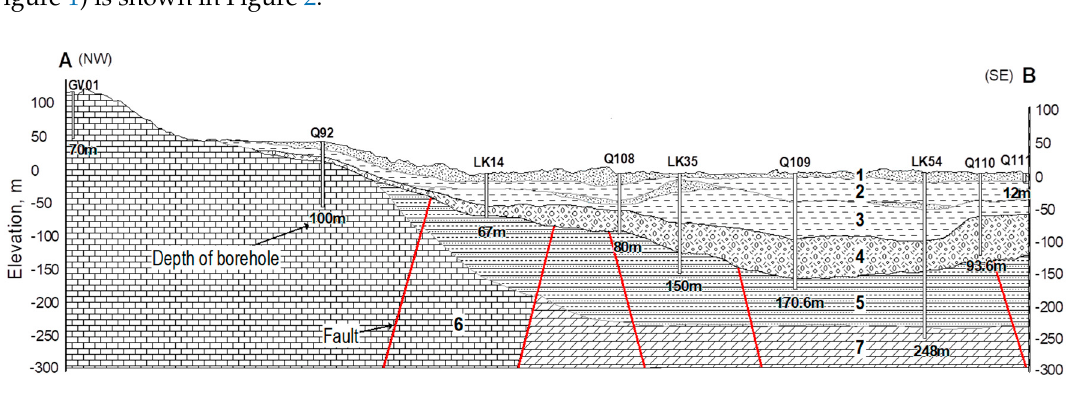
Figure 2. Geological setting of the study region drawn for the transect AB. See explanations for the sequence of the geological formation in the sequence of the geological formation in the text.